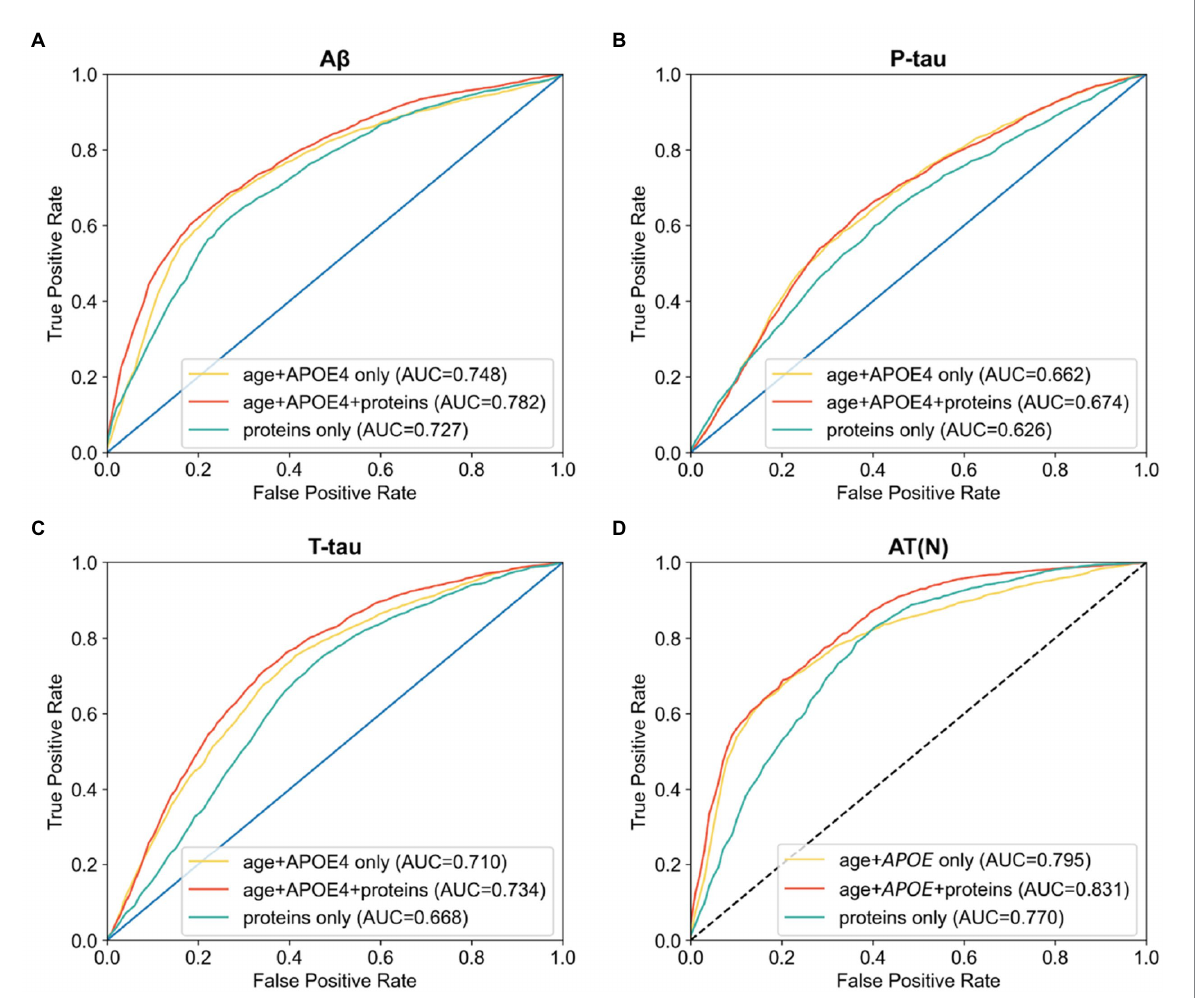
FIGURE 2 AUC ROCs of using age and APOE alone, age and APOE with proteins, and proteins alone to differentiate high vs. low (A) A β , (B) p-tau, (C) t-tau, and (D) combined AT(N) burden. For each target, the panel of proteins with the best performance were